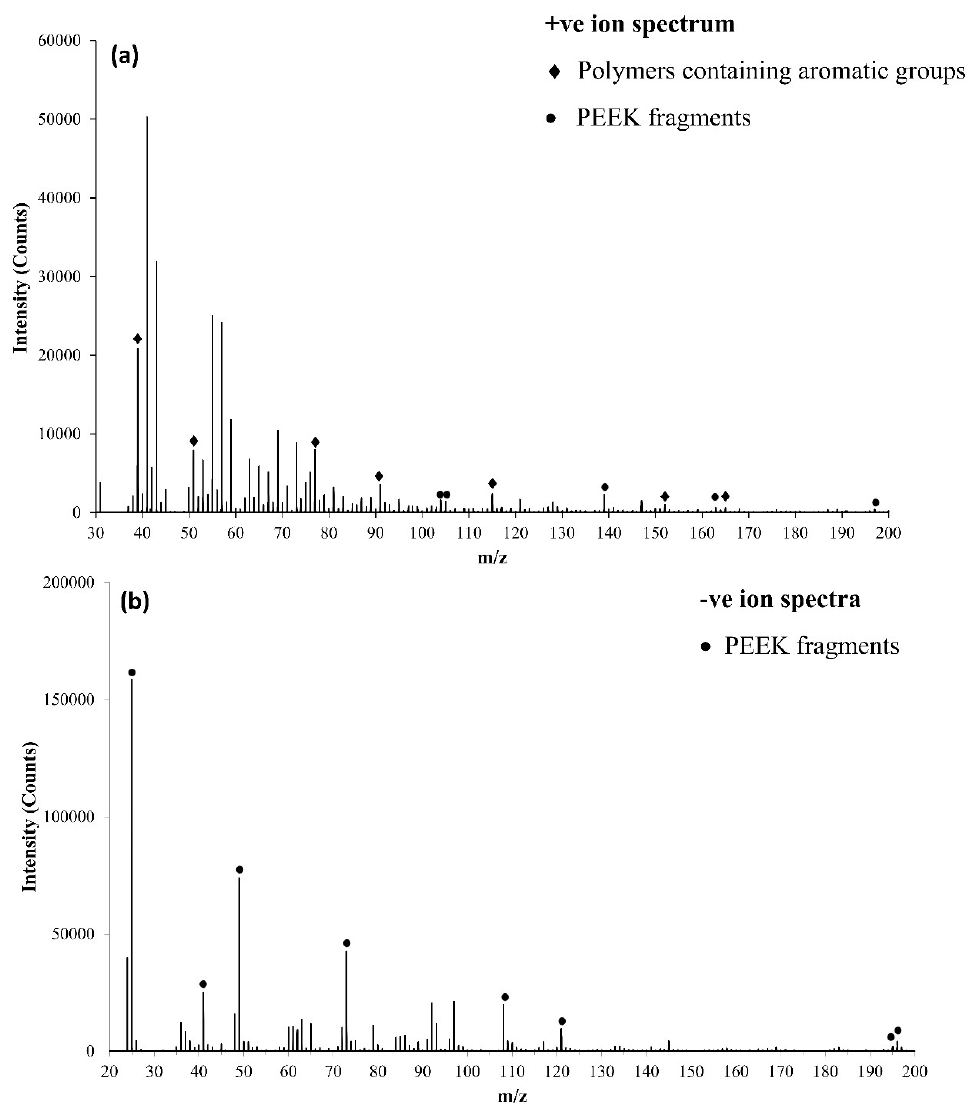
Figure 9. ToFSIMS survey spectra for ( a ) positive ions for the PEEK substrate, ( b ) negative ions for the PEEK substrate.